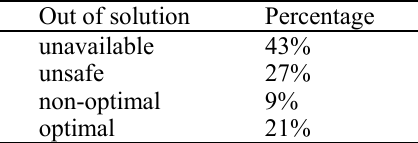
Table 2. The results out of the greedy approach